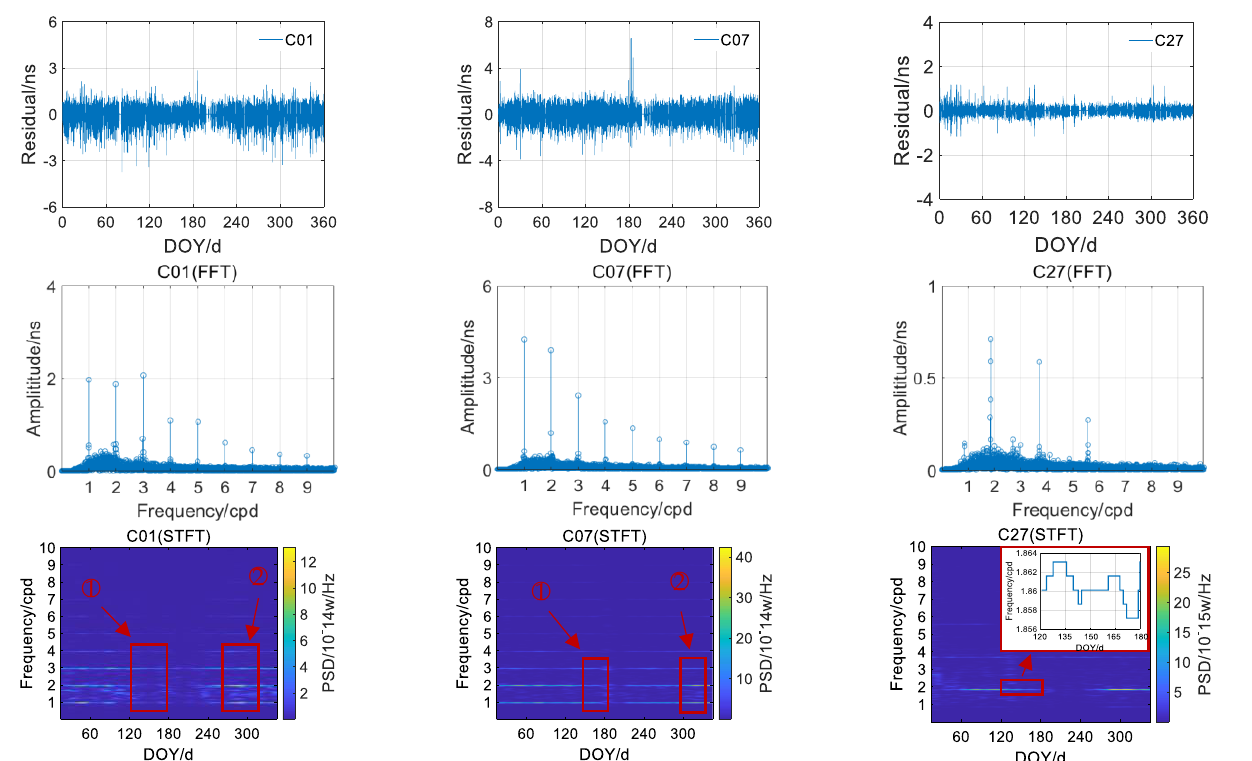
Figure 3. Residuals (top), amplitude spectrum (middle), and spectrogram (bottom) of C01, C07, and C27, respectively.